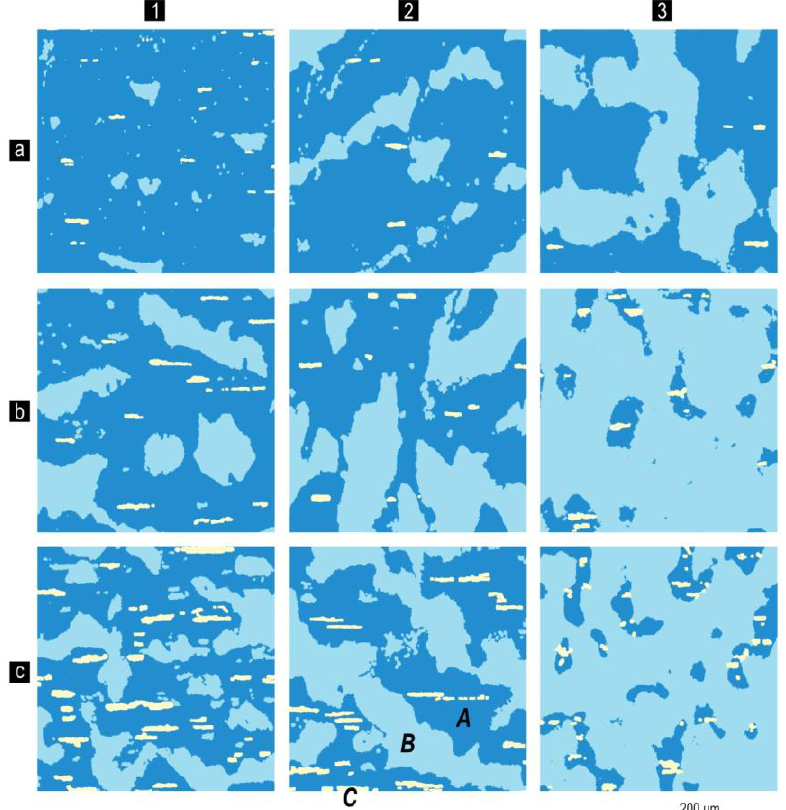
Figure 5. Changes of relationships of structural phase components A, B, and C (are shown in panel c and in Figure 4) in pseudo-single crystal samples of Sm 1-X Zr X (Co 0.702 Cu 0.088 Fe 0.210 ) z alloys in the high-coercivity state with x = 0.13 ( a 1—3); 0.15 ( b 1—3) and 0.19 ( c 1—3), and z = 6.2 (1); 6.4 (2); 6.7 (3) (prismatic plane, the easy magnetization axis is in the image plane and strictly vertical).